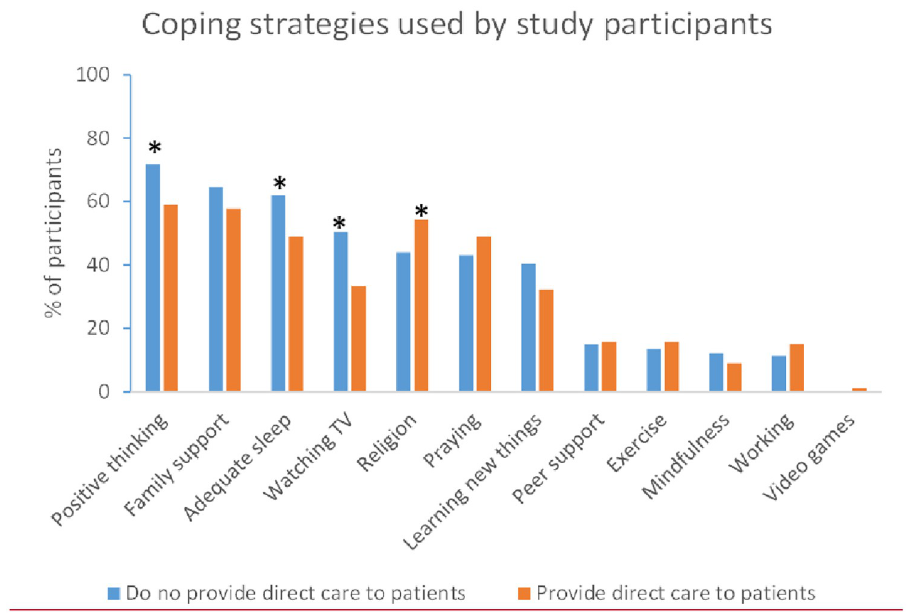
Fig 2. Coping strategies among participants who provide direct care to patients vs. those who do